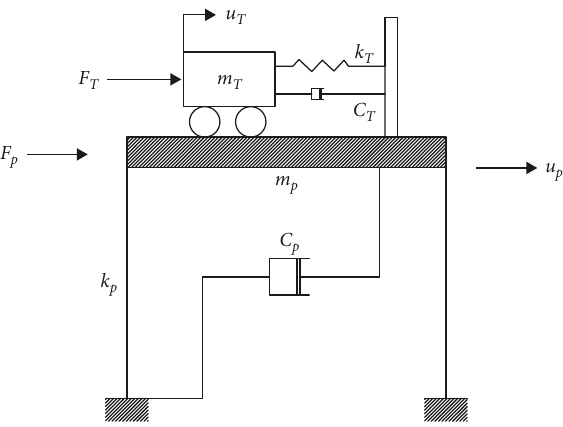
Figure 1: A TMD installed on a SDOF primary